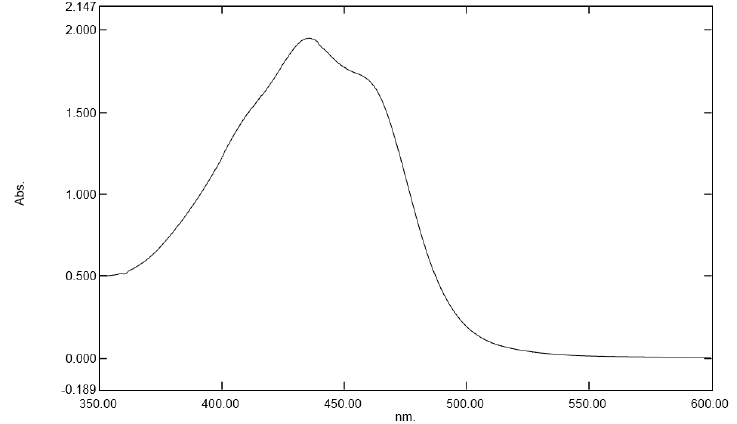
Figure 1. Absorption spectrum between 350 and 600 nm of Gardenia jasminoides fruit extract (dilution at 1/25 ( v/v ) in water).